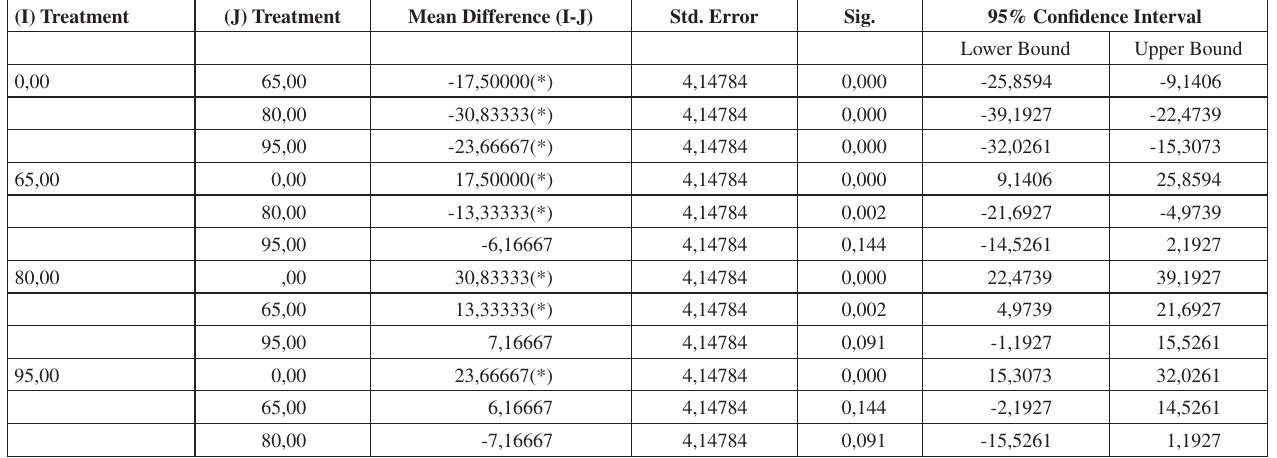
Table 2 .: Analysis of variance tables Multiple Comparisons ( Dependent Variable: germination %) (I)